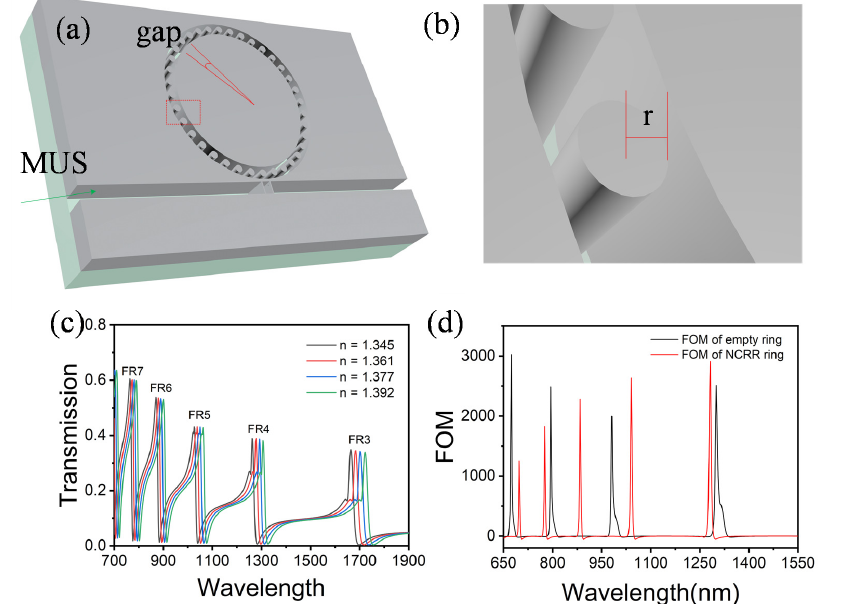
Figure 4. The proposed nanosensor in ( a ) 3D schematic and ( b ) its partial enlargement. ( c ) Transmit- tance spectra of the NDRR sensor, when radius of the silver cylinders r = 5 nm and intervals of the silver cylinders are 90 ◦ . ( d ) FOM of the NDRR sensor and empty ring sensor.